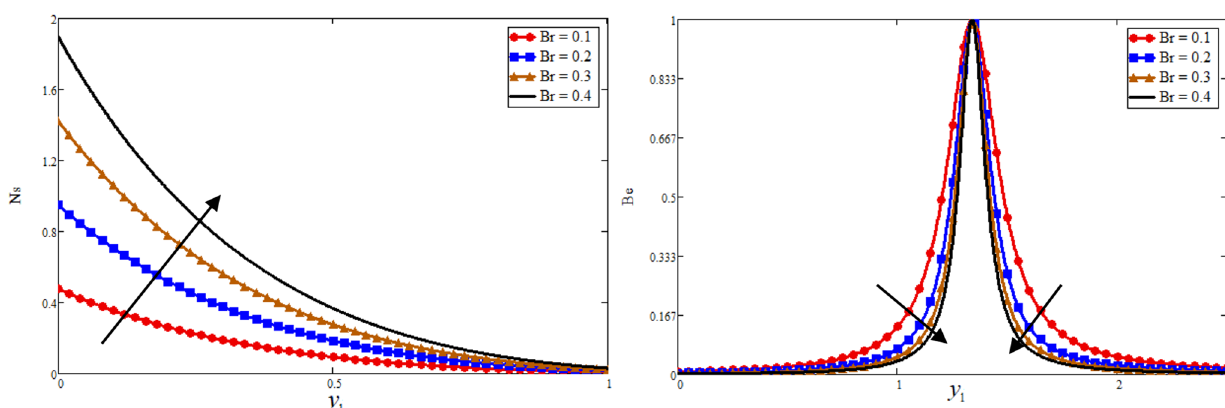
Figure 4. Effect of Br on Bejan number, and entropy